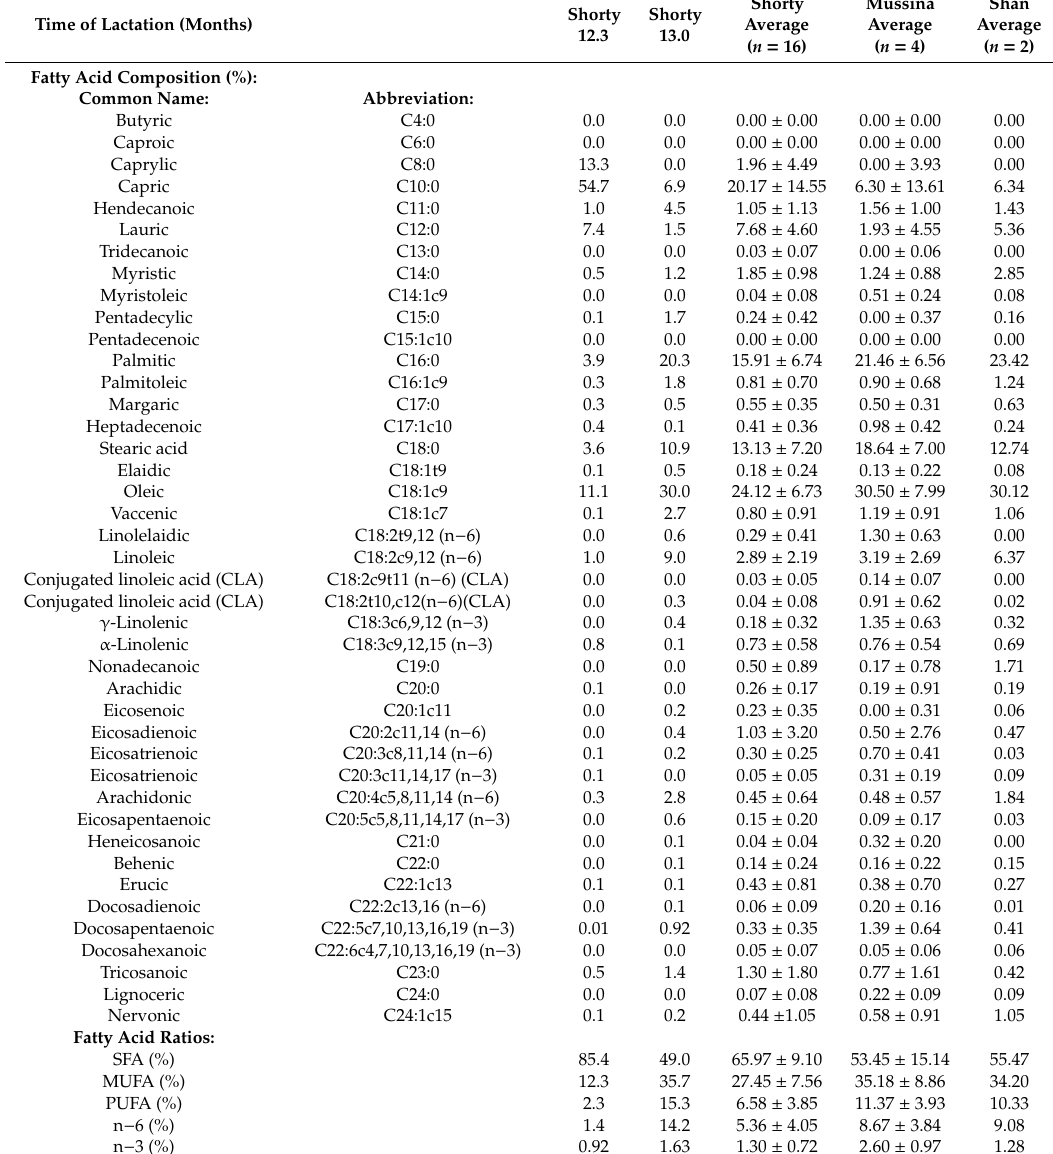
Table 2. Milk total phospholipid fatty acid content of milk from three African elephant cows during lactation. Time of Lactation (Months)